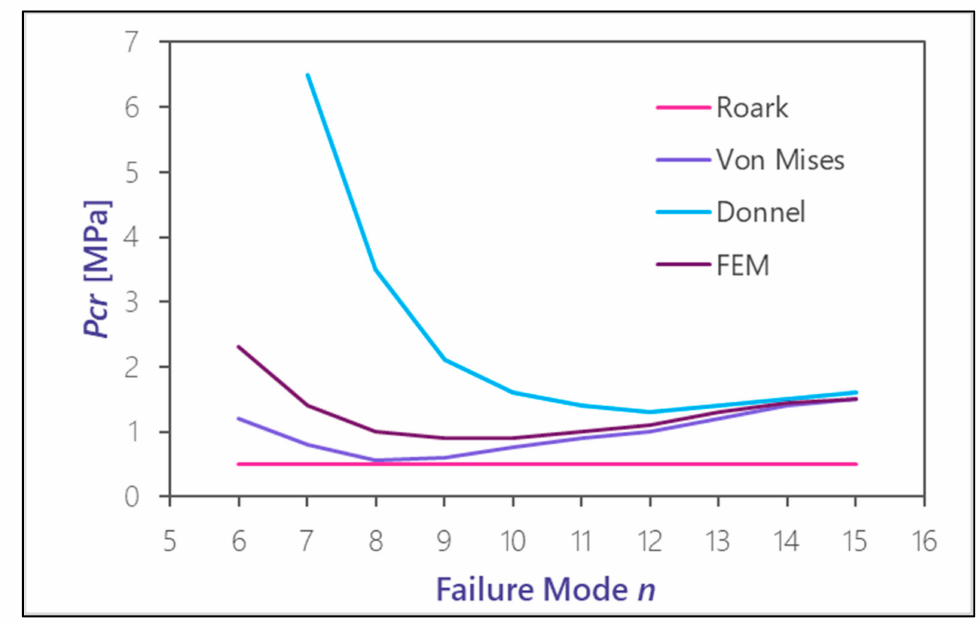
Figure 9. Comparison of the calculated critical buckling pressure without consideration of radial constraint; D / t = 285.7; L = 2.5 m and e = 14